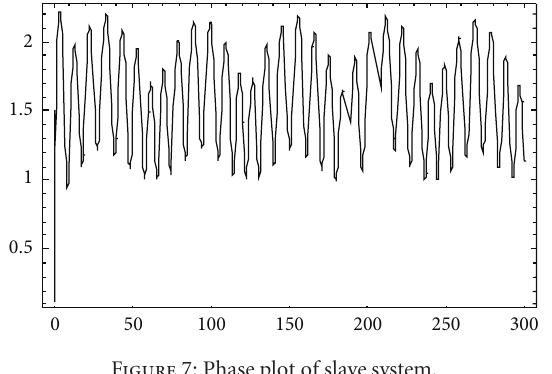
Figure 10: Time series analysis of e 2 ( f ).